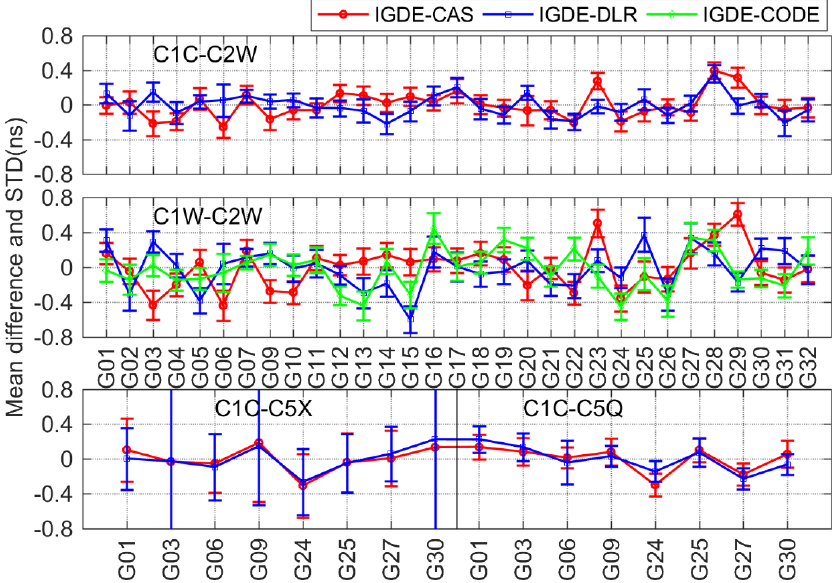
Figure 17. Mean difference and STD of the GPS DCB between IGDE and MGEX products.